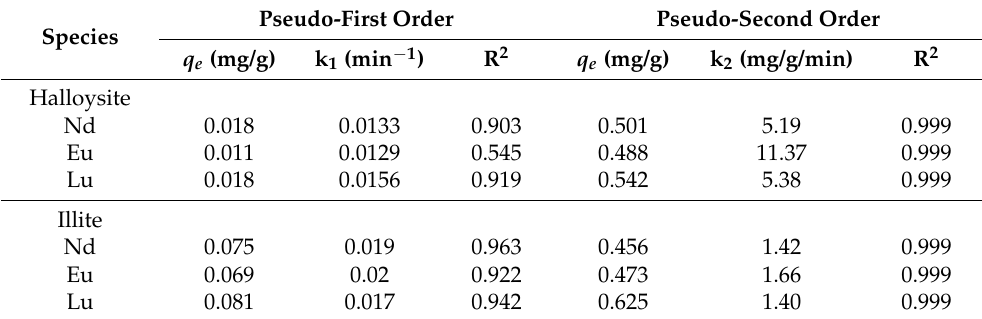
Table 2. Kinetics parameters for the adsorption of Nd 3+ , Eu 3+ and Lu 3+ on halloysite and illite.